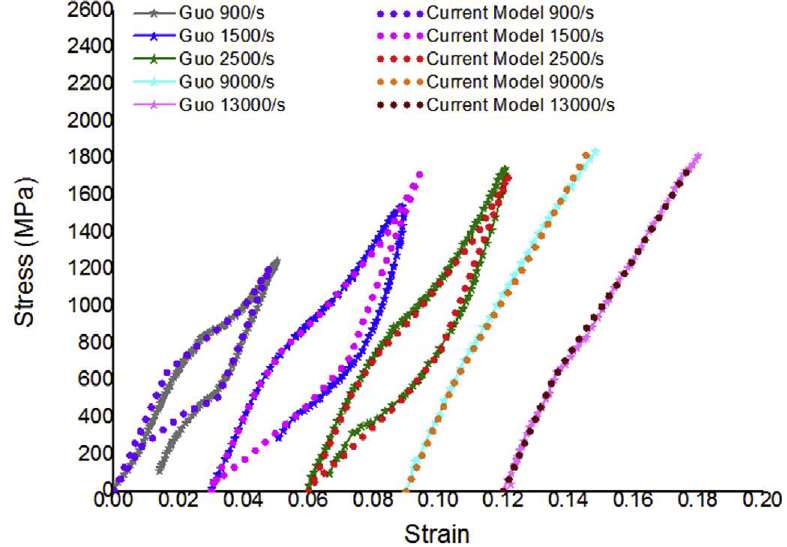
Figure 16. Comparison of stress-strain curves between experiments [27] and simulations [56] at different high strain rates. (Reprinted from Ref. [56], Figure 6, 2017, with permission from